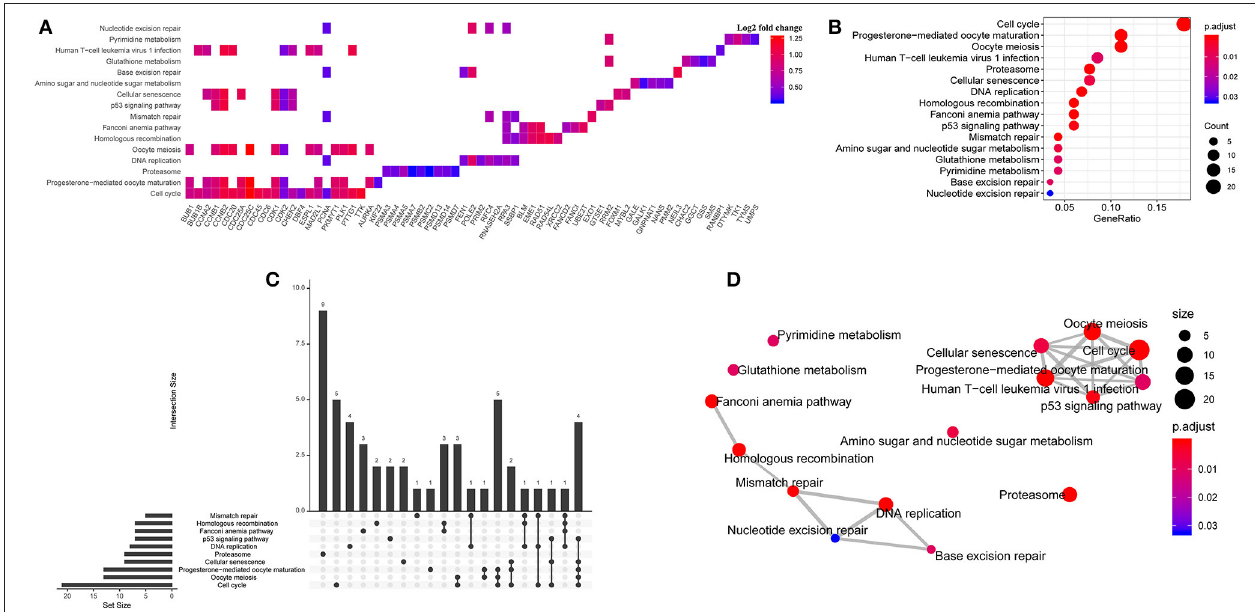
FIGURE 2 | Bioinformatic analysis for potential signaling pathways. (A) The enriched pathways of upregulated differentially expressed genes (DEGs). (B) The Kyoto Encyclopedia of Genes and Genomes (KEGG) enrichment analysis in the TCGA- PDAC datasets. (C) Upset diagram of intersection of DEGs among enriched pathways. (D) The correlation network of KEGG pathways.